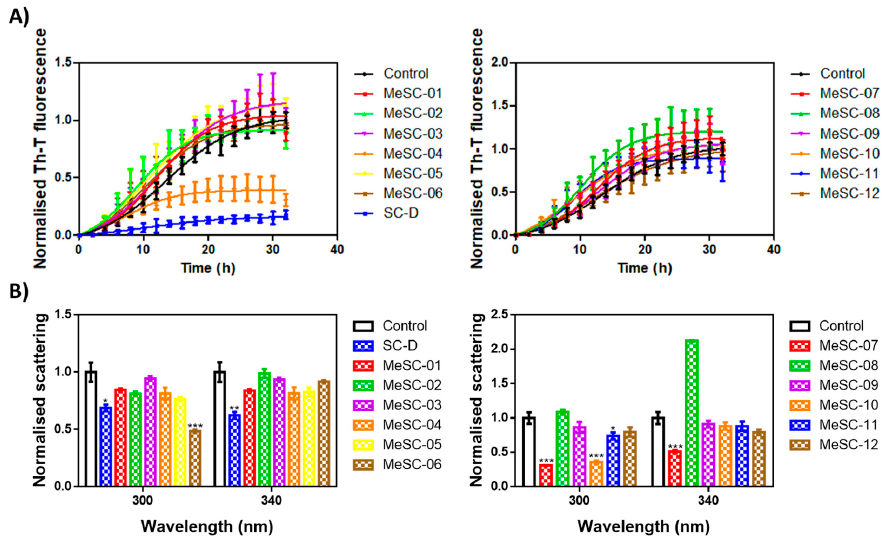
Figure 3. In vitro inhibitory characterization of compounds MeSC-01 to MeSC-12. ( A ) Aggregation kinetics of α -Syn in the absence (black) or presence of 100 µM concentrations of the different compounds (colored) compared to SC-D (blue, left panel). Th-T fluorescence is plotted as a function of time. ( B ) Light scattering measurements at 300 and 340 nm of end-point aggregates in the absence (black) or presence of 100 µM concentrations of the different compounds (colored) compared to SC-D (blue, left panel). The statistical significance was determined by a one-way ANOVA test with Dunnett’s multiple comparison (* p < 0.05; ** p < 0.01; *** p < 0.001). For the SC-D and MeSC-04 compounds, the Th-T levels at the final point were statistically significant ( p < 0.0001). Th-T fluorescence and light scattering are plotted as normalized means; error bars represent SEs of mean values for N ≥ 3 in each experiment.